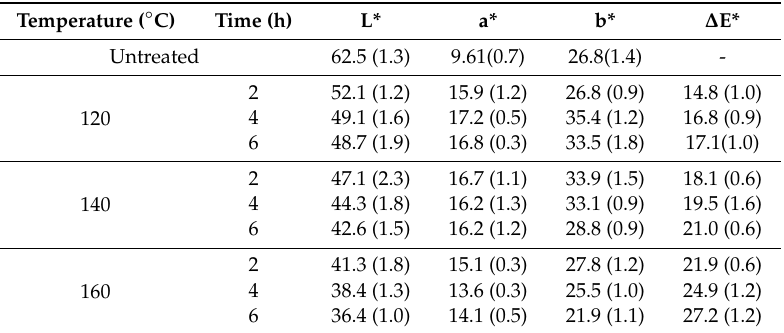
Table 1. The color index of bamboo scrimber after hot oil